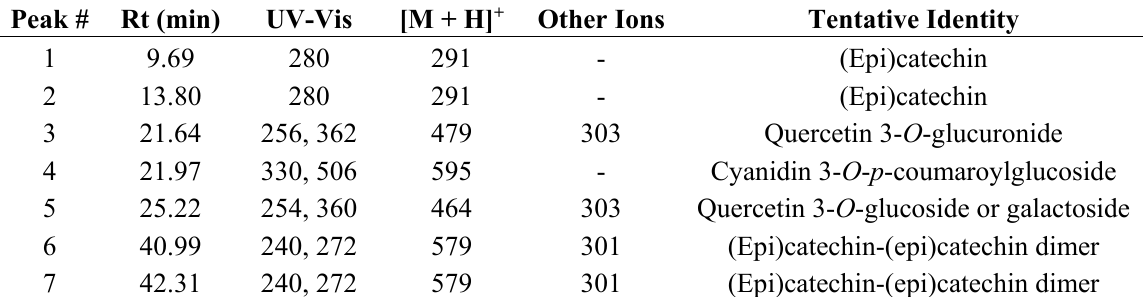
Table 3. Spectral characteristics of the polyphenol tentatively identified in the RGP extract obtained with 0.5% ( w / v ) LA, after 320 min at 40